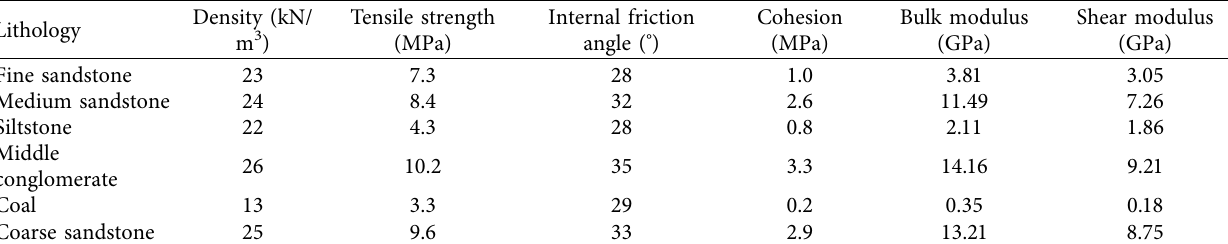
Table 2: Parameters of the rock